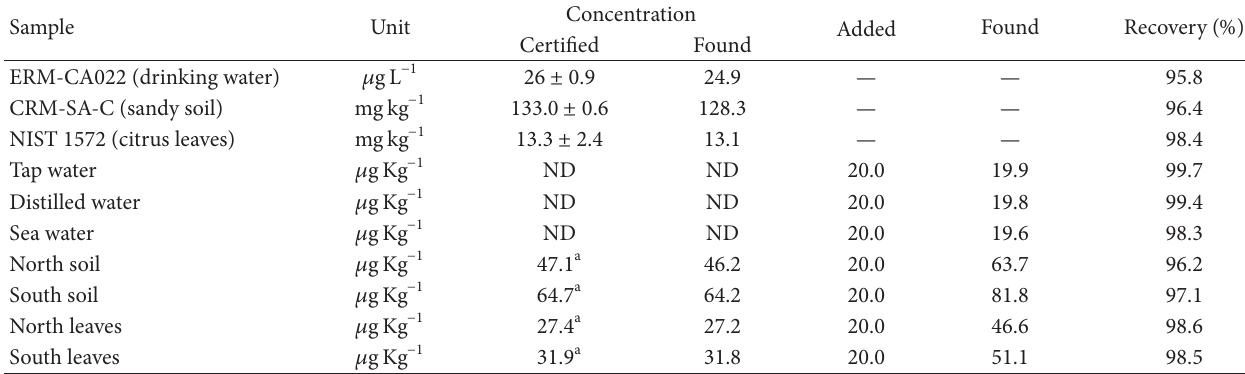
T 4: Recovery of determination of Pb(II) ions in certi�ed reference